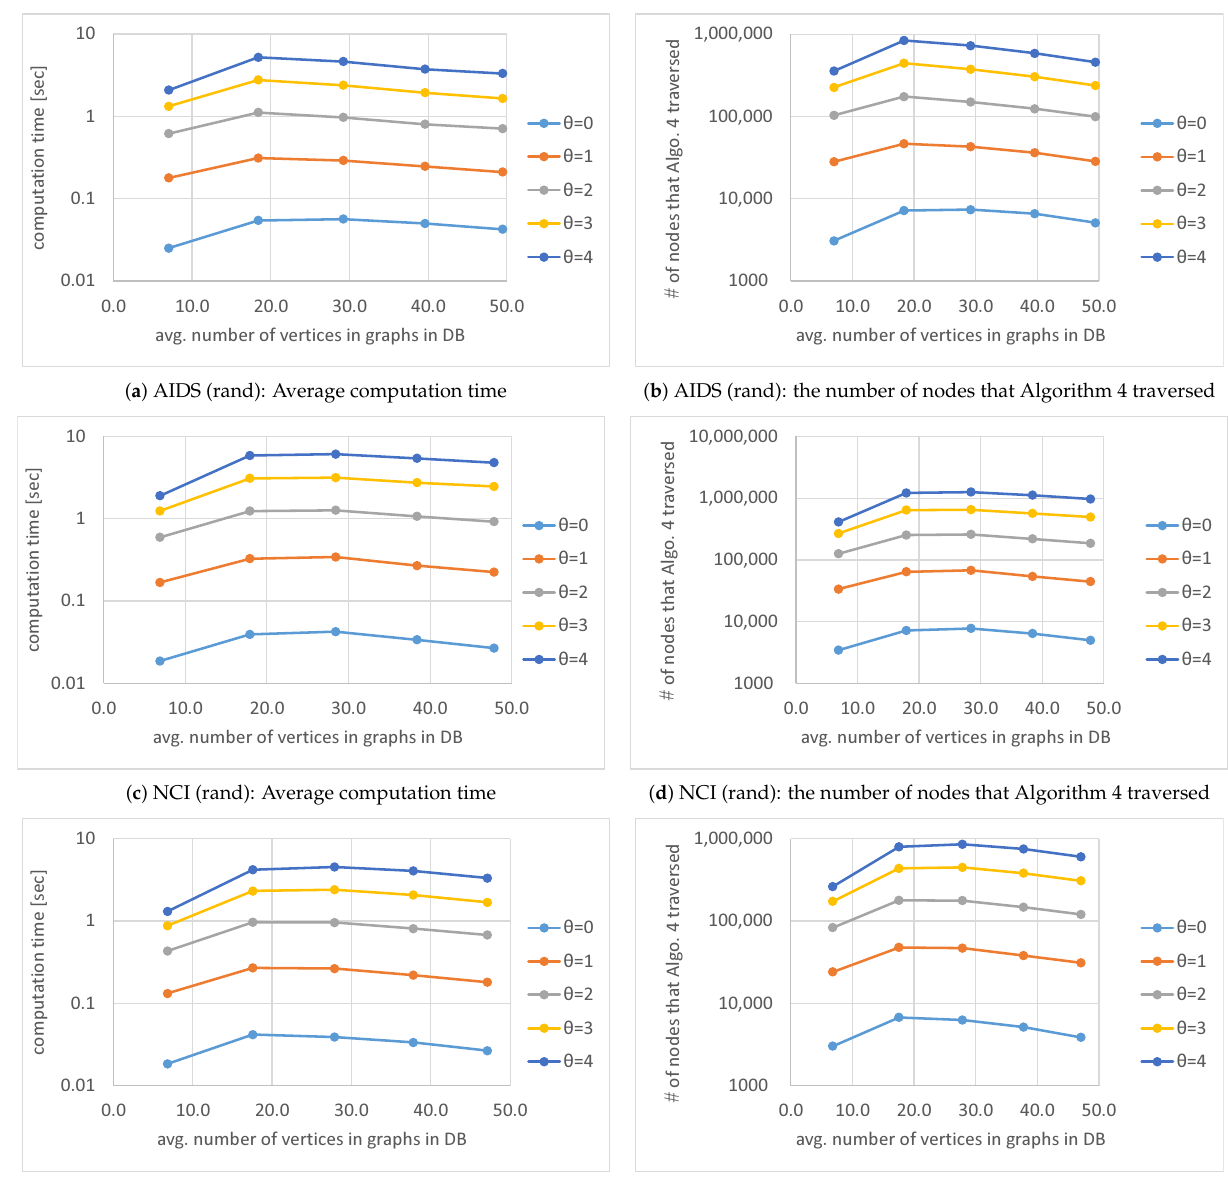
Figure 14. Average computation time and the average number of nodes that Algorithm 4 traversed for various numbers of vertices in graphs in a database and various thresholds θ . Next, we conducted experiments for Algorithm 4 with Equations (15) and (17). Figure 15 shows the computation times for various numbers of graphs in the databases and various thresholds. The computation times with Equation (17) were much shorter than those with Equation (15). This is because the number of graphs reachable by editing a graph q (cid:48) ⊆ q θ times increases exponentially and editing graphs with Equation (17) is limited to the relabeling of vertices and edges, which is faster than the insertion and deletion of vertices and edges that are required with Equation